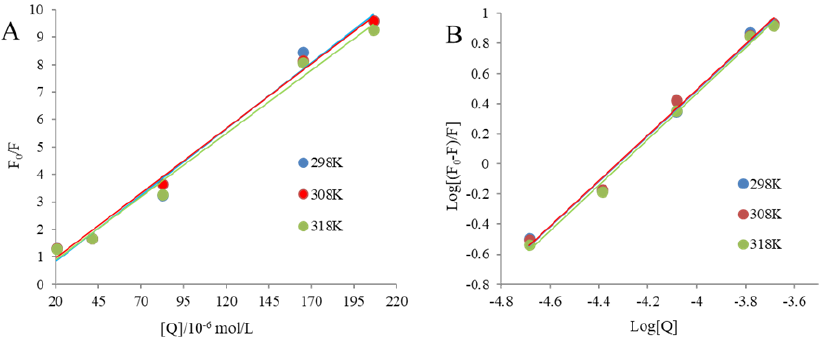
Figure 4. Stern – Volmer plots of LPI quenched by C3G (0 – 0.2%) at 298 K, 308K, and 318K ( A ), and the double-logarithmic regression plots of 0.5 mg/mL LPI in the presence of C3G (0 – 0.2%) at 298 K, 308K, and 318K ( B ). Table 2. Quenching constant, binding constants, and thermodynamic parameters of LPI-C3G com- plexes at 298, 308, and 318 K.